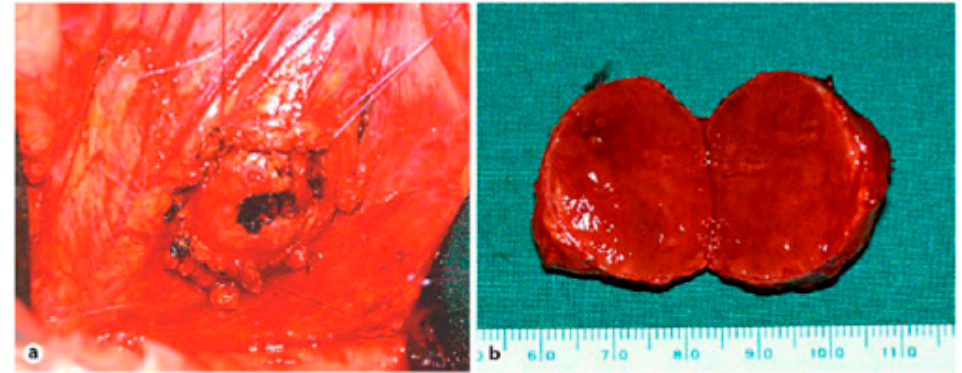
Figure 9. ( a ) Situsintra-operatory showing the tumor before enucleation. The tumor is flanked by four sutures that attach and enucleate from the surrounding tissue. ( b ) Specimen showing tumor 3 cm in diameter